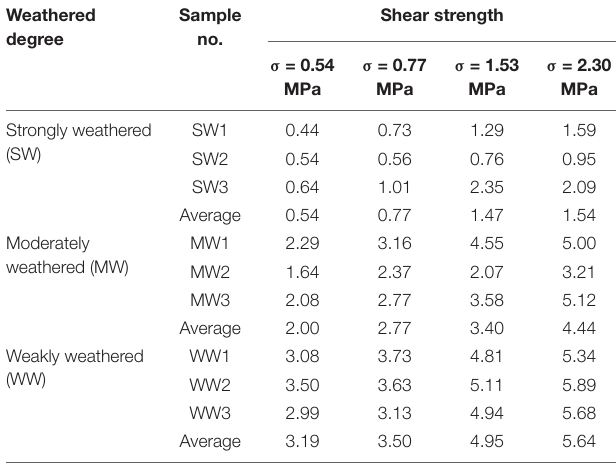
TABLE 1 | Shear strength of diorite-porphyrite samples with different degrees of weathering.